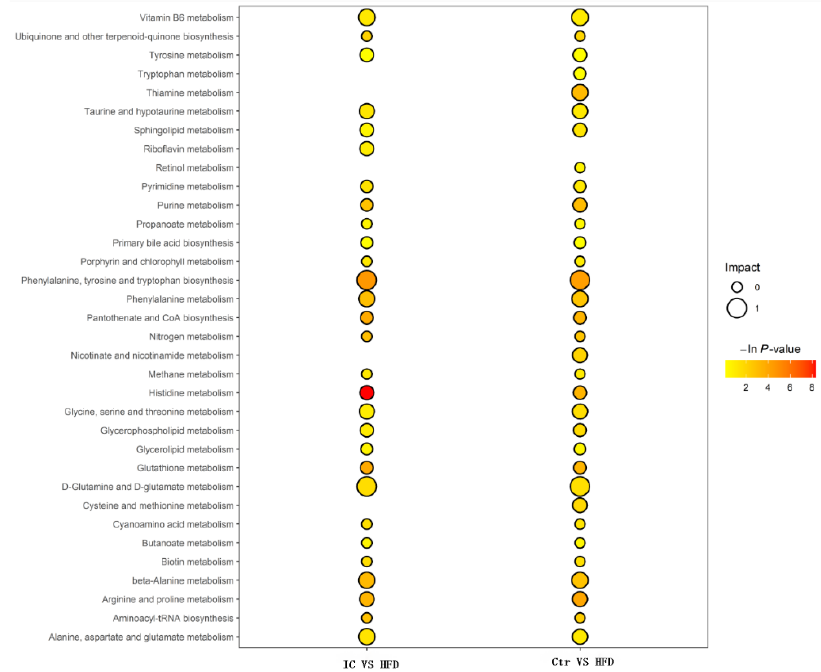
Figure 10. Bubble plot of KEGG pathway analysis.